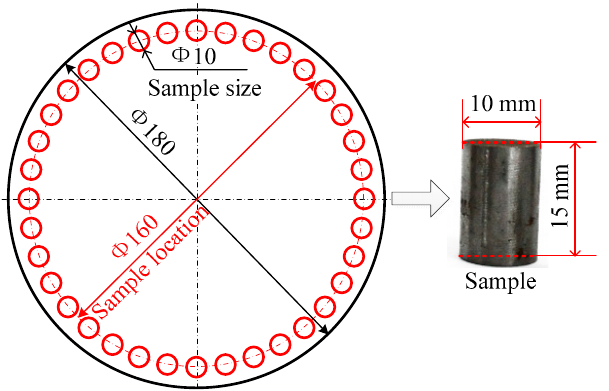
Figure 1. Size and position of test specimens.